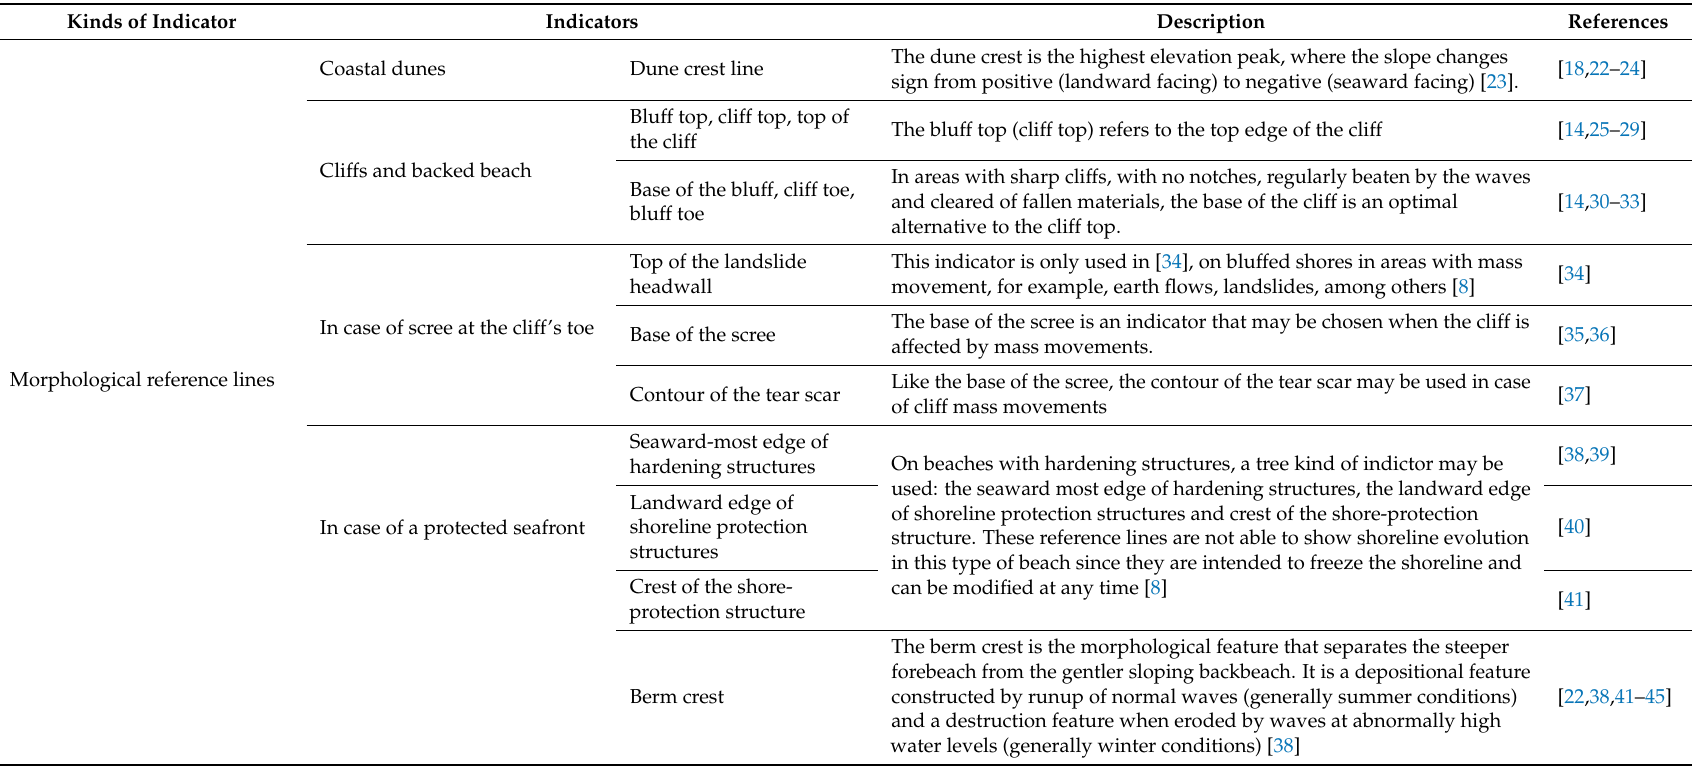
Table 2. Summary of shoreline indicators (adapted from [8,9]